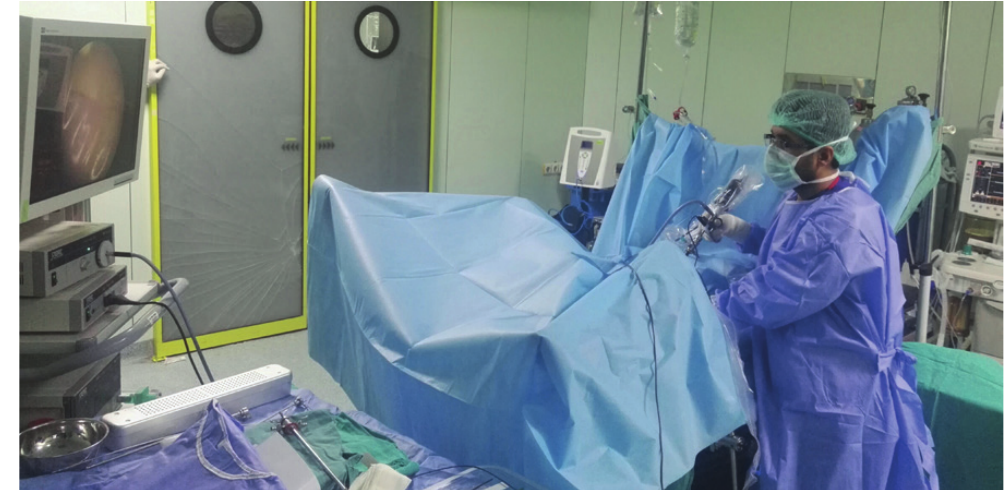
figure 4 - position of the surgeon at the left side of